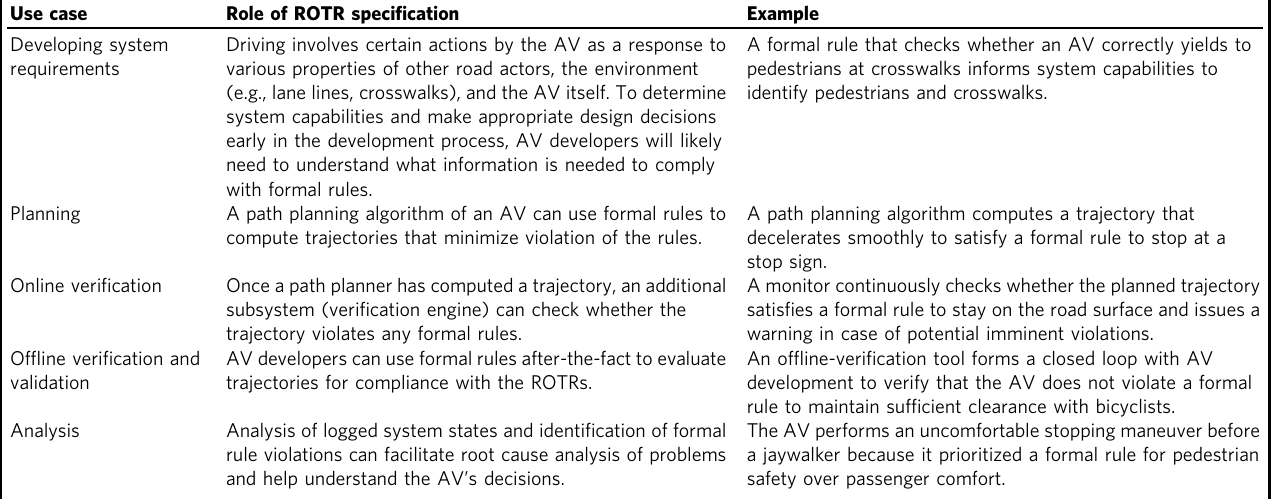
Table 1 Applications and use cases for formal